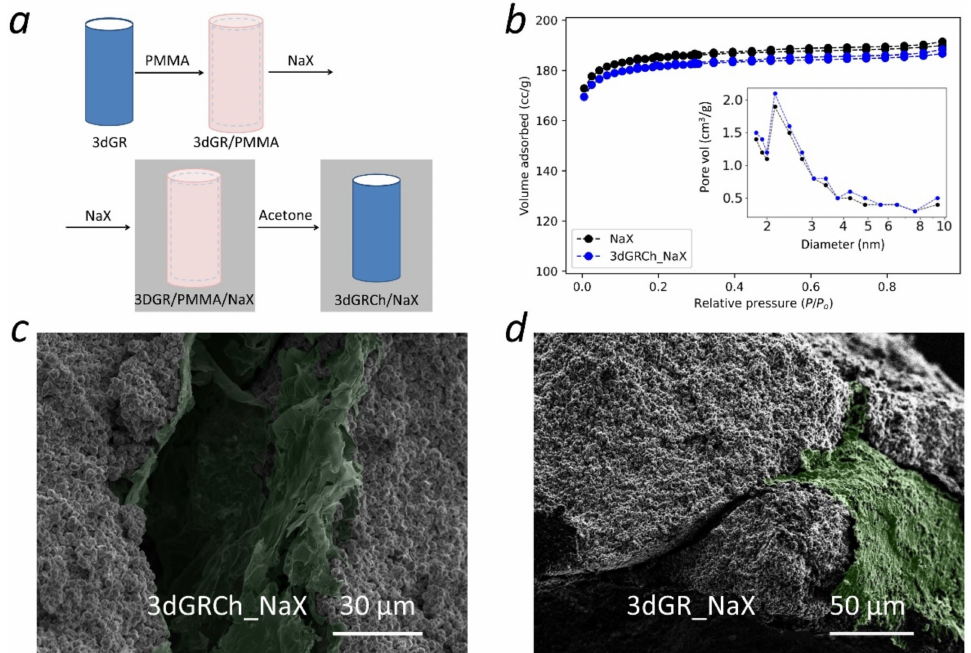
Figure 1. ( a ) Schematic of the synthesis of 3dGRCh-NaX using PMMA as sacrificial polymer to protect the micro-channels of 3dGR. SEM images of 3dGRCh-NaX and 3dGR-NaX composites; ( b ) N 2 adsorption–desorption isotherms at 77 K for NaX (black-round) and 3dGRCh-NaX (blue-round) composite. Inset: pore size distribution based on N 2 adsorption–desorption isotherm. y -axis is incremental pore volume (cm 3 /g) and x -axis is diameter (nm). ( c ) NaX with infiltrated 3dGRCh thermal additive binder coating, and ( d ) 3dGR-NaX without preserved channeling. The 3dGR was falsely colorized in green for better